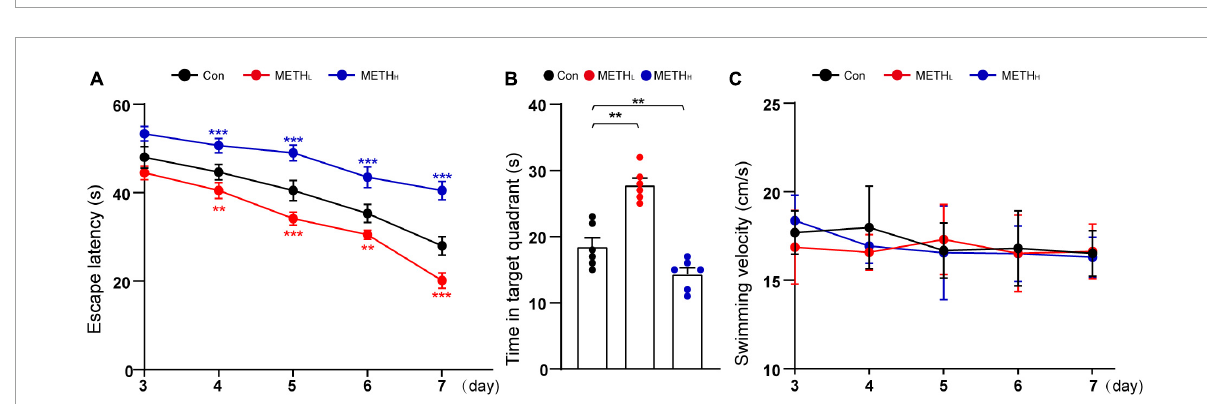
FIGURE7 Effect of low dose and high dose methamphetamine (METH) on spatial memory. (A) Escape latency in MWM test. Two – way repeated measures ANOVA, day: F (4, 60) = 281.836, p < 0.001, treatment: F (2, 15) = 424.790, p < 0.001, day × treatment: F (8, 60) = 8.727, p < 0.001, 3th day: F (2, 26) = 32.477, p < 0.001, 4th day: F (2, 26) = 53.226, p < 0.001, 5th day: F (2, 26) = 95.271, p < 0.001, 6th day: F (2, 26) = 71.518, p < 0.001, 7th day: F (2, 26) = 162.271, p < 0.001. (B) Time in quadrant of different group mice. One-way ANOVA, F (2, 26) = 39.562, p < 0.001. (C) Swimming velocity in MWM test. Two – way repeated measures ANOVA, day: F (4, 60) = 1.206, p = 0.318, treatment: F (2, 15) = 0.462, p = 0.639, day × treatment: F (8, 60) = 0.528, p = 0.830, 3th day: F (2, 26) = 1.297, p = 0.302, 4th day: F (2, 26) = 1.29, p = 0.304, 5th day: F (2, 26) = 0.217, p = 0.808, 6th day: F (2, 26) = 0.044, p = 0.957, 7th day: F (2, 26) = 0.097, p < 0.908. n = 6. ** p < 0.01, *** p < 0.001 by One – way ANOVA or Two – way repeated measures ANOVA and Bonferroni’s post hoc